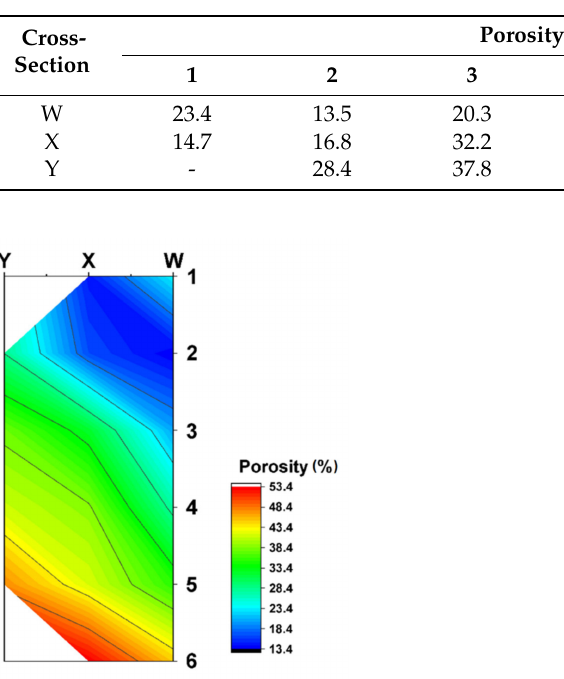
Table 8. Average values of the porosity for individual areas of the sample.